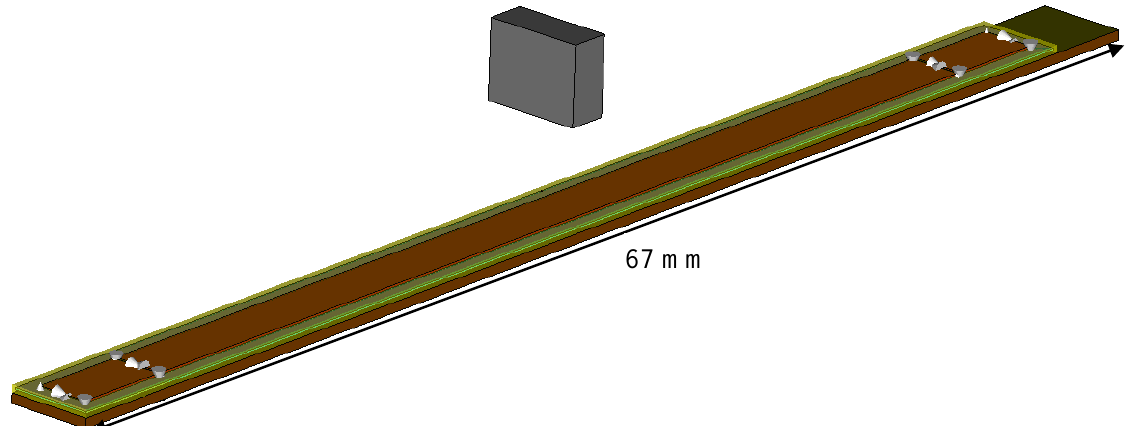
Figure 3. Micro-PLCD sensor